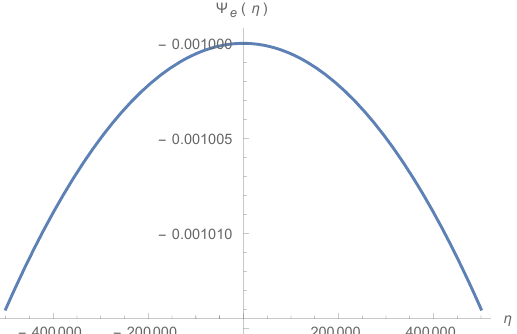
Figure 8. Time evolution of Φ e in the Jordan frame for the initial conditions Φ e ( 0 ) = 10 − 2 , − 3 , Φ (cid:48) Ψ ( 0 ) = 0, Ψ (cid:48) ( 0 ) = 0. The background evolution is the one obtained by assuming e ( 0 ) = − 10 e e the same initial conditions as mentioned in the caption of Figure 2.